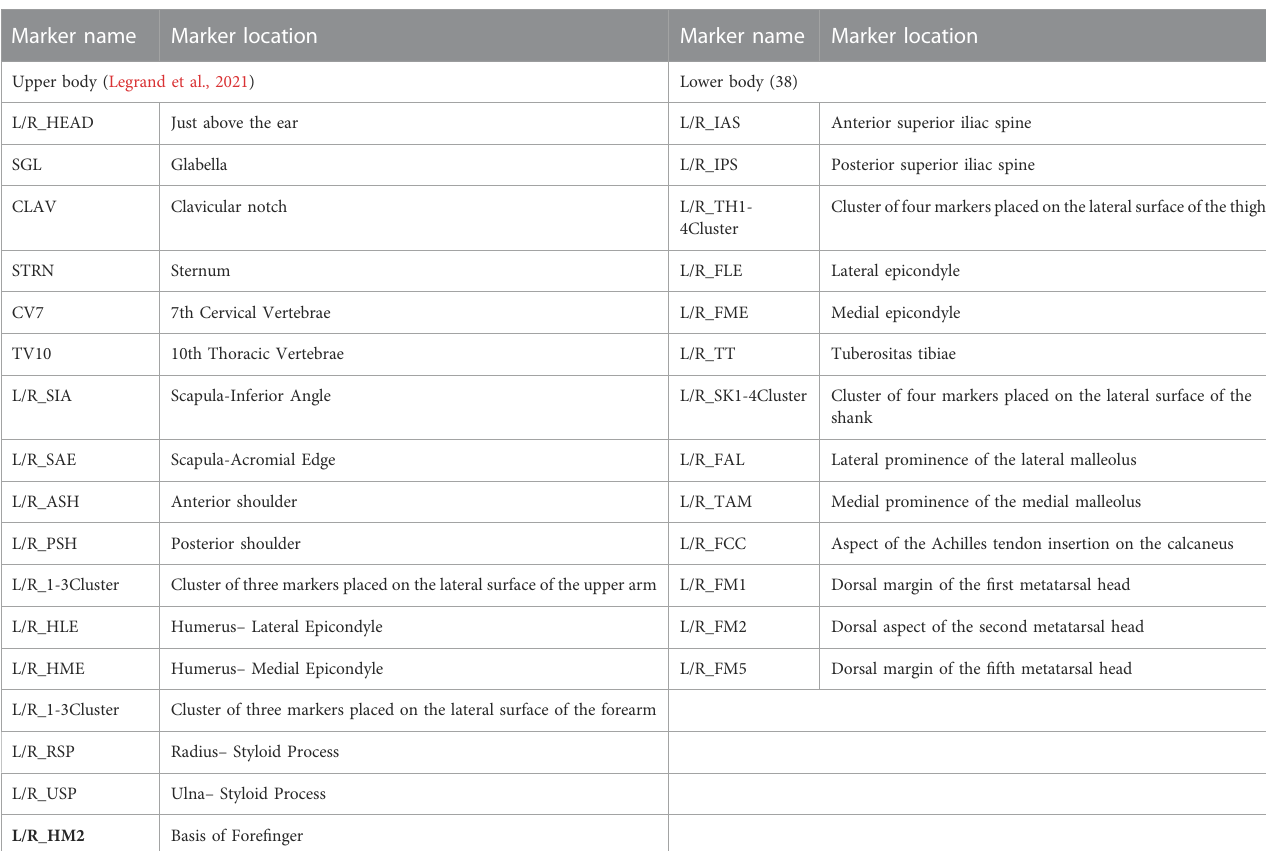
(Figure 2). Joint angles of the ankle and knee joints in the sagittal plane and angles of the hip, pelvis, and trunk joint in the sagittal, coronal, and horizontal planes at FC timepoint were derived from Visual